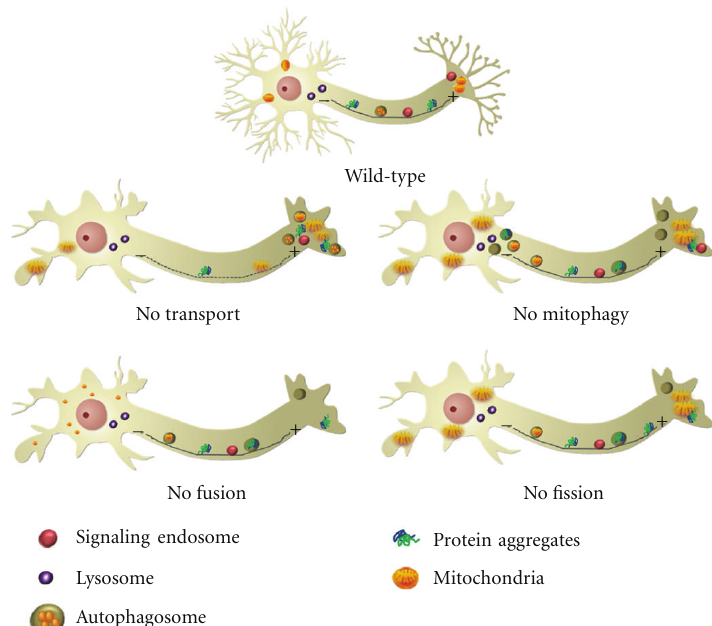
Figure 1: Potential susceptibility of neurons to mitochondrial dysfunction and impaired mitochondrial turnover. ( Wild type ) In healthy neurons, mitochondria, prosurvival signals associated to signaling endosomes, and autophagomes enclosing damaged organelles or protein aggregates are able to travel long distances from the cell periphery to perinuclear region in the cell body, where most lysosomes are concentrated. ( No transport ) Disruption of microtubule network and subsequent defects on retrograde transport prevent the proper distribution of mitochondria and the e ffi cient transport of autophagy substrates towards lysosomes for degradation, which can lead to defects in energy supply and cargos clearance by autophagy. ( No mitophagy ) Blockage of autophagic activity seems to be responsible for the accumulation of damaged mitochondria, toxic protein products, aggregates, and leaking autophagic vesicles, all of which have a negative e ff ect on neuronal functioning and survival, precipitating the “dying-back”-type of axonal degeneration. ( No fusion ) The absence of mitochondrial fusion may result in an accumulation of damaged mitochondria or decreased healthy mitochondria at the nerve terminal. Mitochondria secondarily have defects in motility that prevent proper distribution within the axon and in the periphery. ( No fission ) In the absence of mitochondrial fission, most of the mitochondrial population is extensively long and interconnected, and a subset shows ultrastructural defects and dysfunction. The large mitochondria clusters within dendrites are not e ffi ciently transported and/or engulfed by autophagosomes towards cell body for lysosomal degradation. (MT: microtubule tracks oriented along the axon with plus (+) ends distal and ( − ) ends proximal to the cell